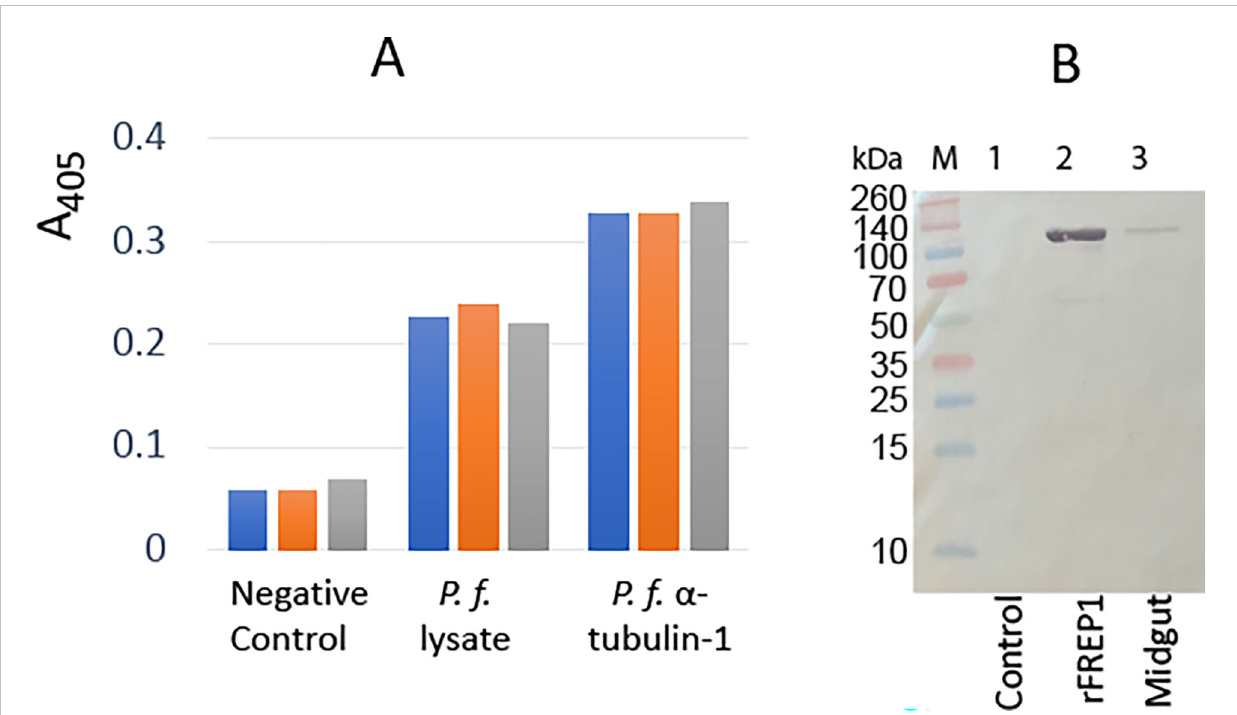
FIGURE 9 P. falciparum a -tubulin-1 interacts with An. gambiae FREP1. (A) ELISA showed that P. falciparum a -tubulin-1 bound to An. gambiae FREP1. A bar exhibits the actual value of A 405 from one replicate, and there are three replicates per treatment. (B) P. falciparum a -tubulin-1 pulled down FREP1 from mosquito midgut lysate, which was detected by a western blotting assay. .